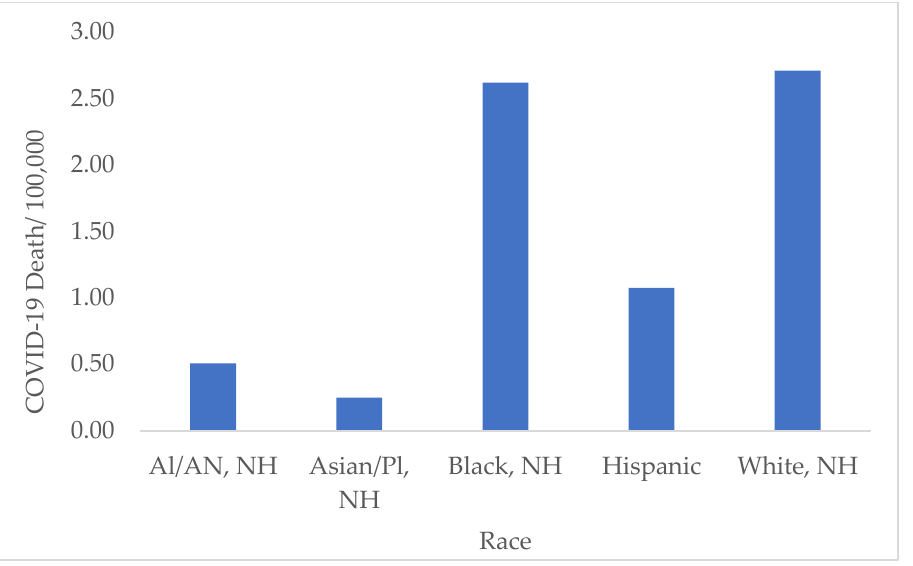
Figure 9. Average rate of COVID-19 deaths by race in all states from 2020 to 2022. The highest death rates were observed among the White and Black/African American Populations. Note: AI: American Indian, AN: Alaska Native, NH: Non-Hispanic, Pl: Pacific Islander. Table 3. Weekly mean and standard deviation for COVID-19 cases and death rates grouped by race and